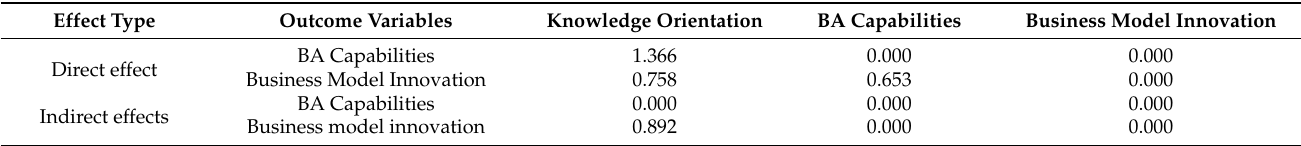
Table 5. Test results of mediating effects of BA